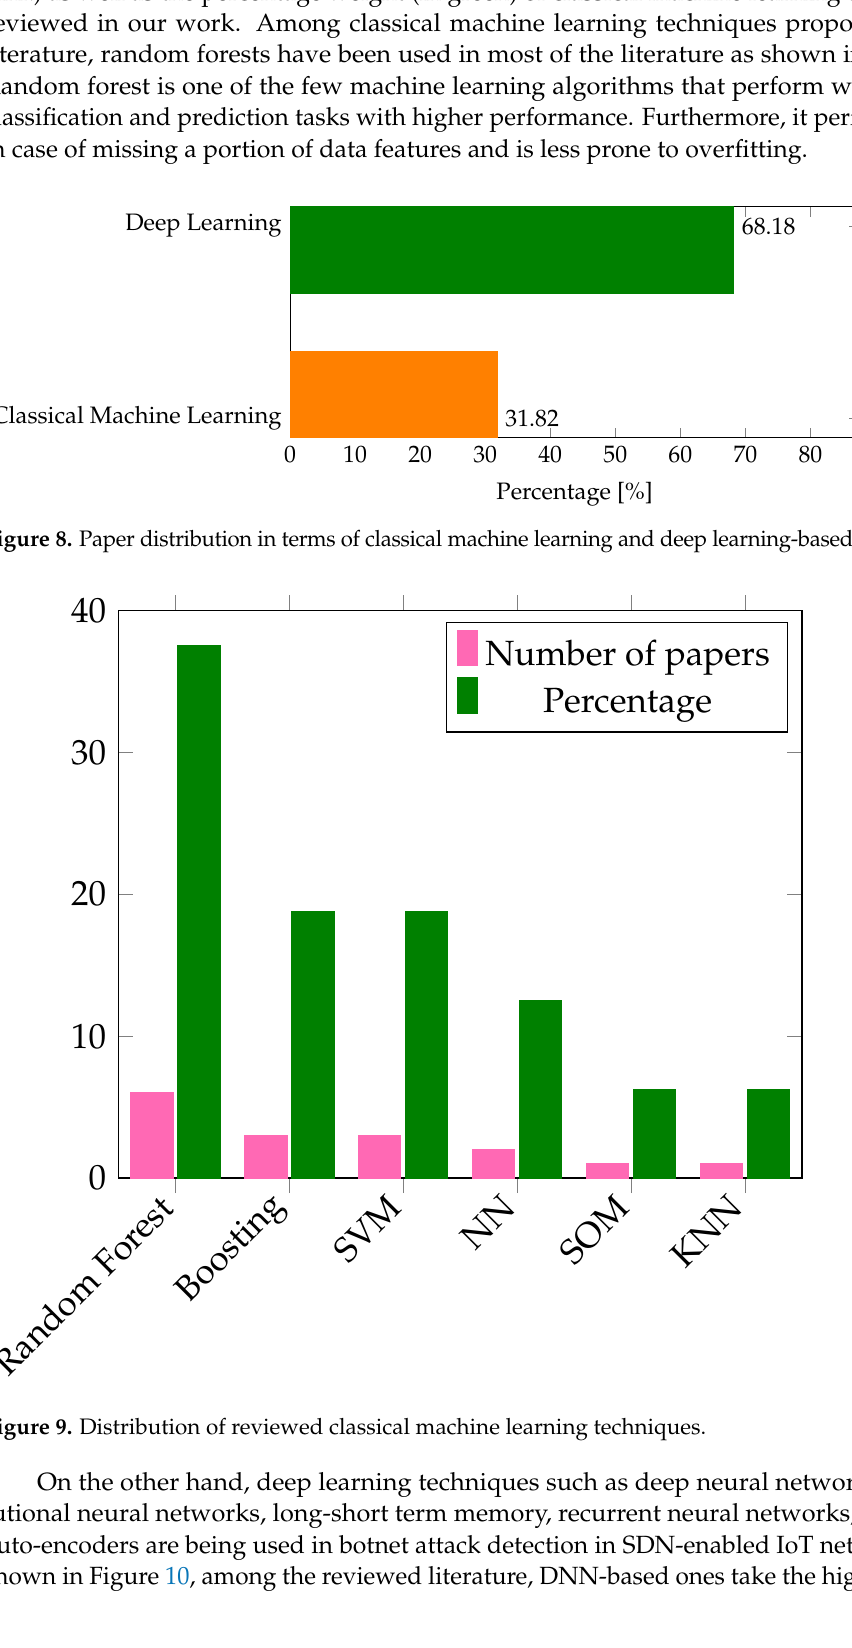
Figure 9. Distribution of reviewed classical machine learning techniques